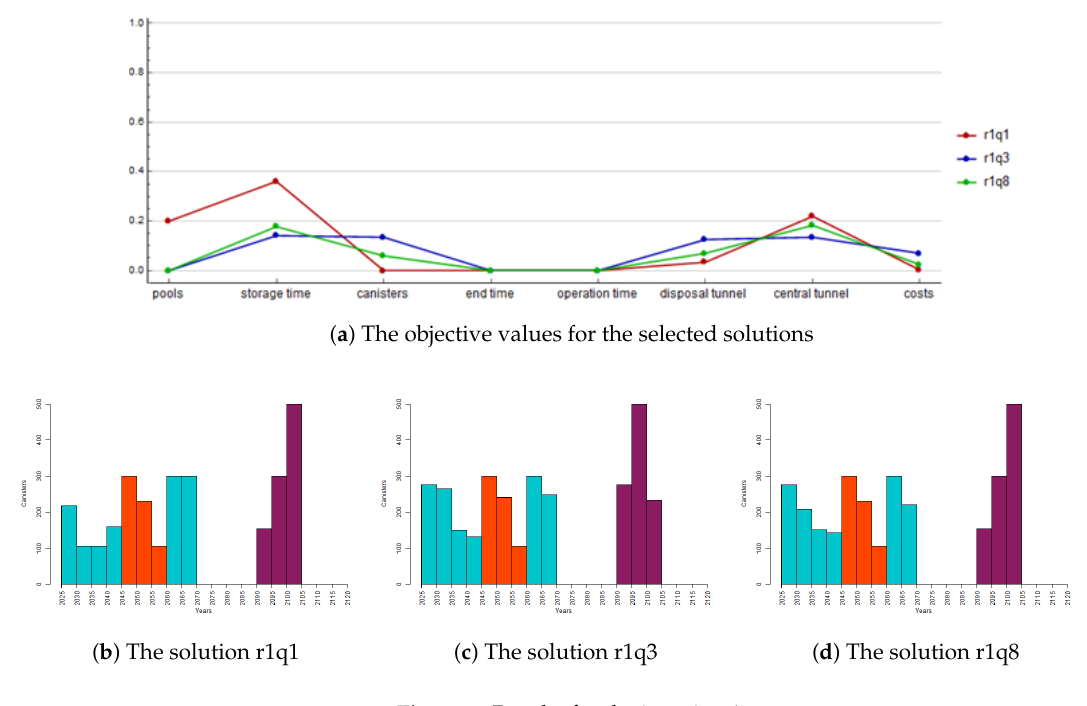
Figure 5. Results for the iteration